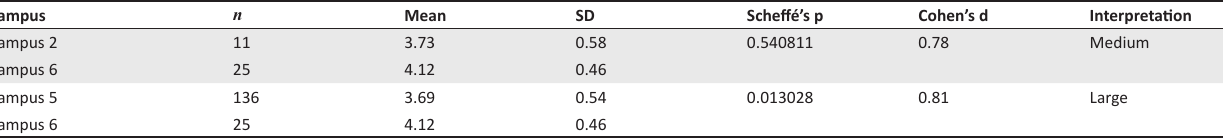
TABLE 6: The practical significance of the impact of campus on organisational identification.